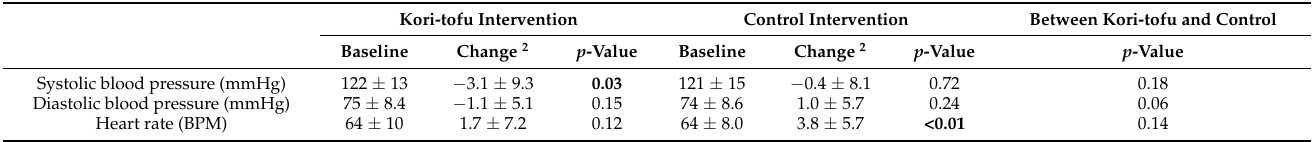
Table 4. Blood pressure values at baseline and change after 4 weeks intervention with Kori-tofu or control intervention 1 . Kori-tofu Intervention Control Intervention Between Kori-tofu and Control